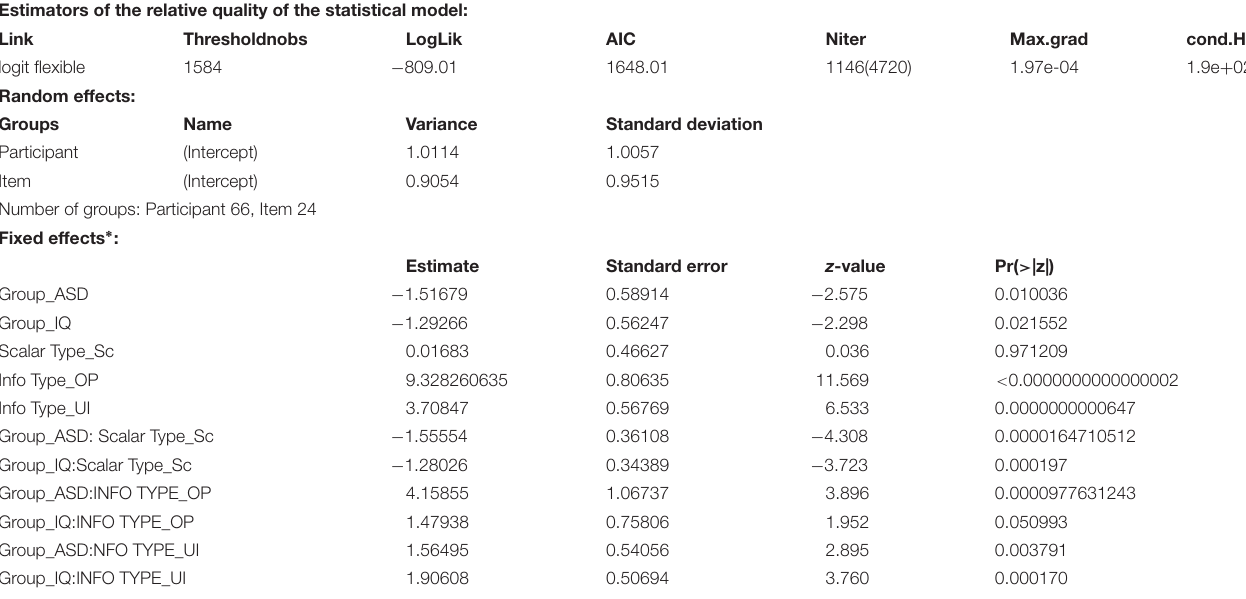
TABLE 5 | A complete description of the final model for Experiment 2: Group ∗ Scalar Type + Group ∗ Informativeness Type + (1|Participant) + (1|Item). Estimators of the relative quality of the statistical